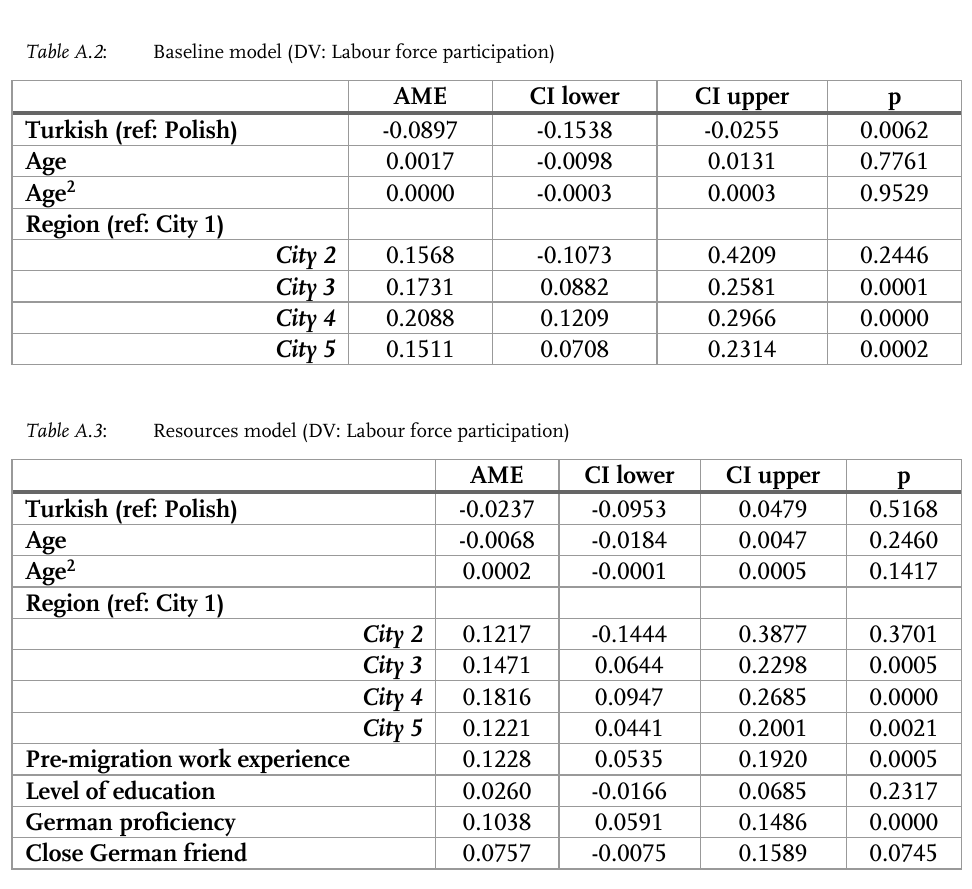
Quantitative studies of migrant labour market integration in Germany (published 2000-early